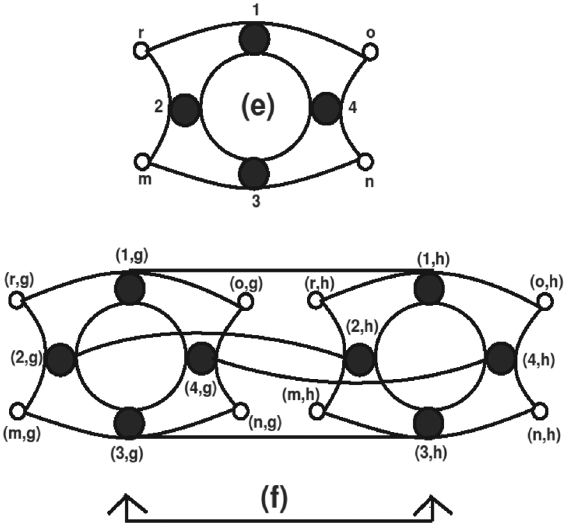
G + iff T = T T 1 2